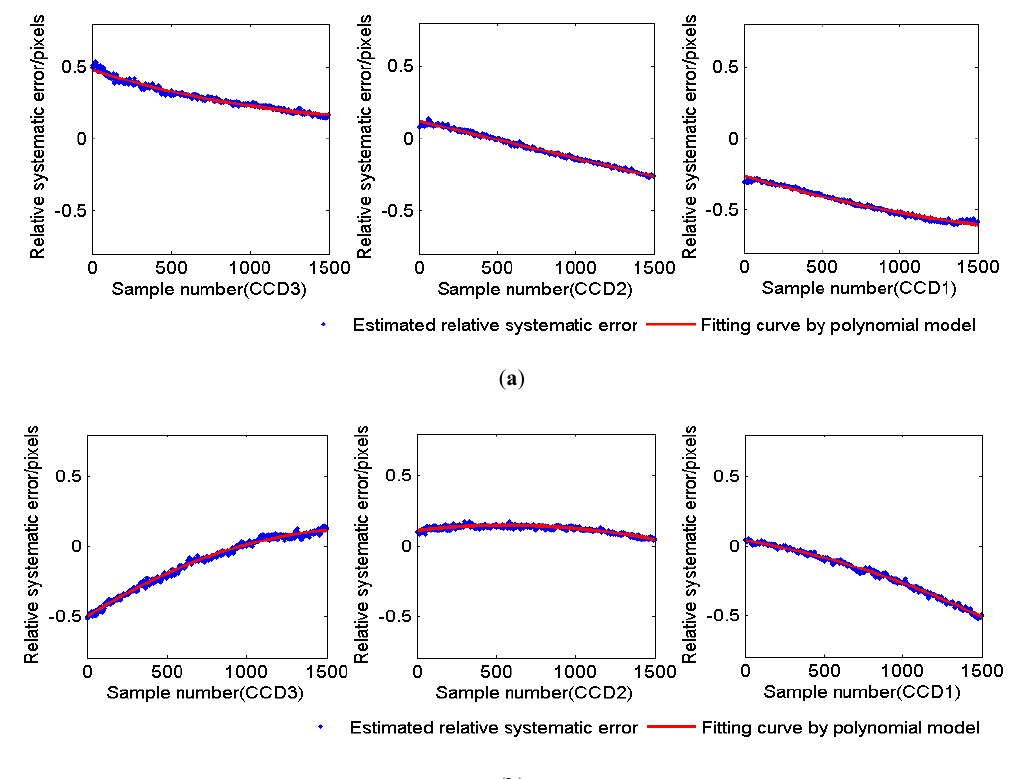
Figure 6. Relative systematic error between B1 and B2 in Scene A. ( a ) Across the track and ( b ) along the track.